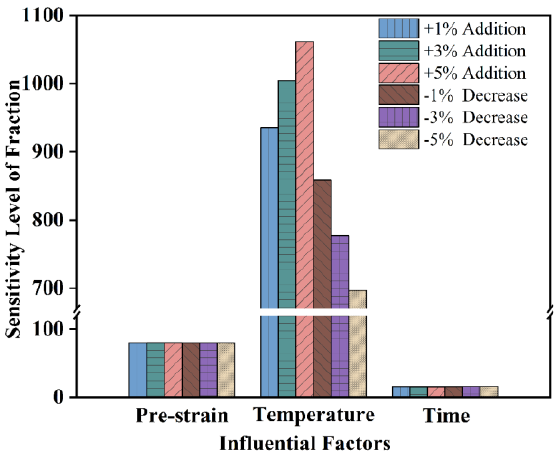
Figure 13. Sensitivity of input parameters to static globularization fraction.